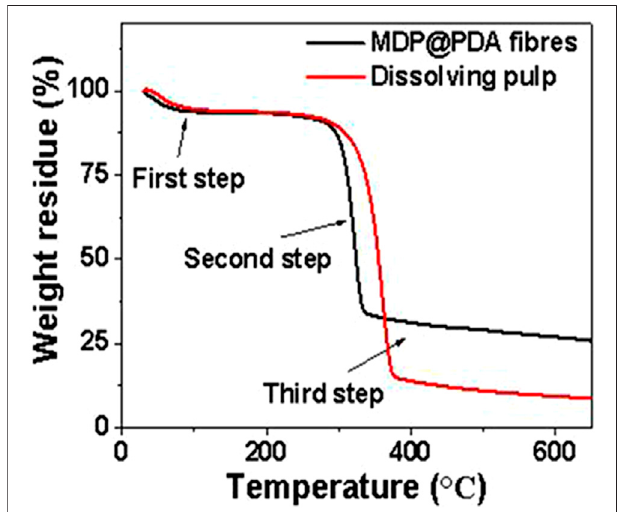
FIGURE 7 | TG curve of dissolving pulp and MDP@PDA fi